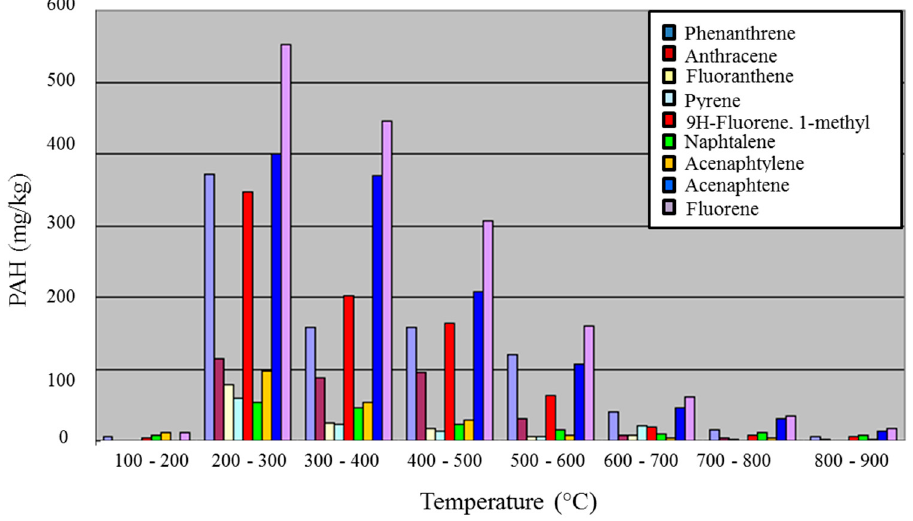
Figure 7. Emission of gaseous PAH versus temperature for paste C.